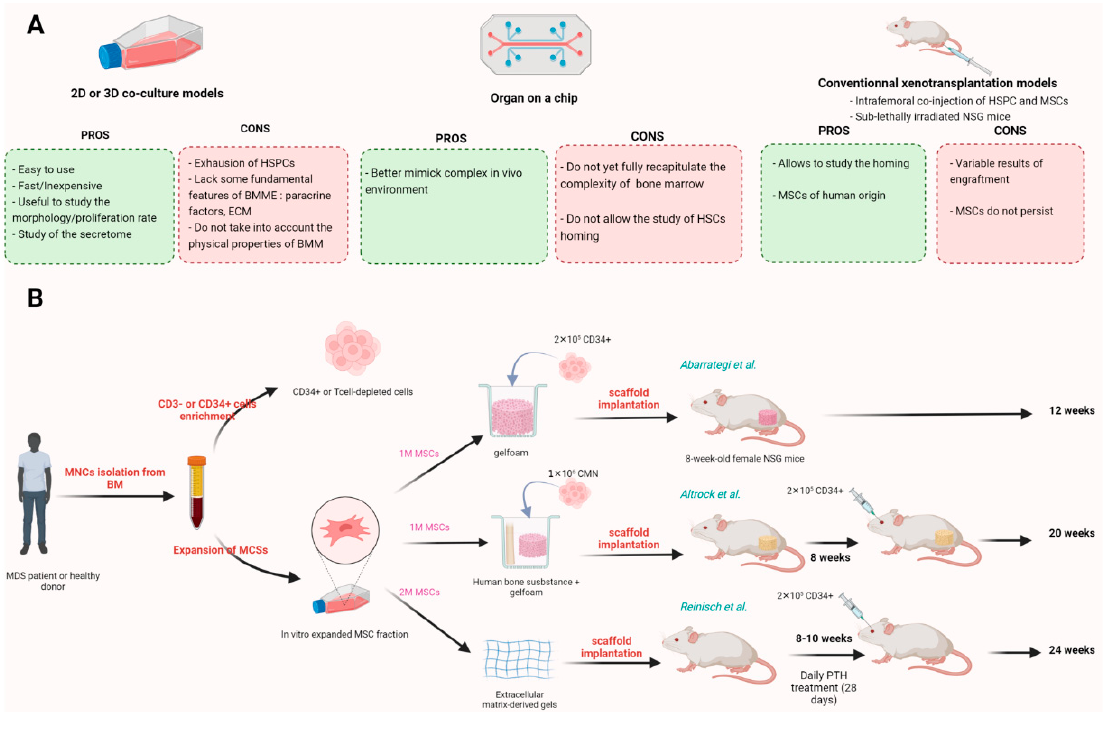
Figure 3. Overview of different approaches to study the effect of the mesenchymal niche on hematopoiesis. ( A ) Historically, 2D and 3D culture models have been used. However, organs on CHIP better model the complexity of the bone marrow. Xenotransplantation models are generally used to study hematological diseases, but the percentage of engraftment is very low when applied to MDS. ( B ) In an effort to improve MDS engraftment, models of humanized bone marrow-like structures have been generated. All these models are based on a preliminary amplification step of primary MSCs, which are then seeded on a scaffold which can be of different origin. The HSPCs are then either implanted directly into the scaffold or injected intravenously into the mouse